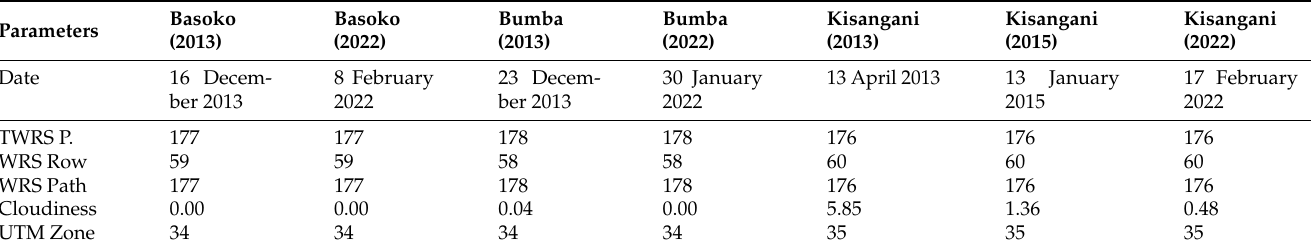
Table 2. Main technical characteristics of the Landsat-8 OLI / TIRS imagery.